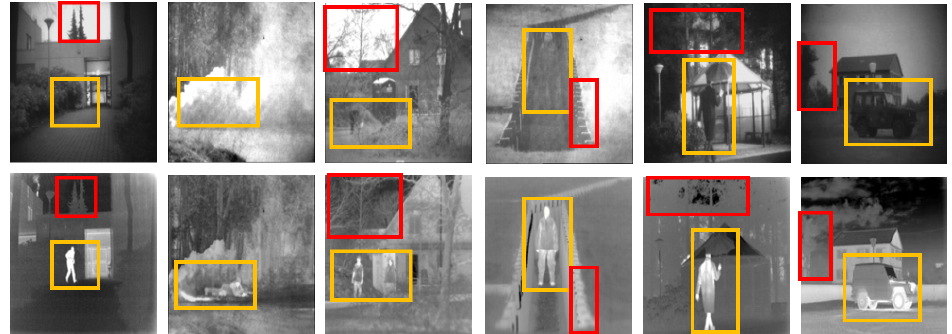
Figure 1. Illustration of visible ( top row ) and infrared ( bottom row ) images of the same scene. It is clear that the visible images contain rich texture details ( top row ), as show in the red boxes, while the infrared images have high contrast ( bottom row ), as shown in the orange boxes.